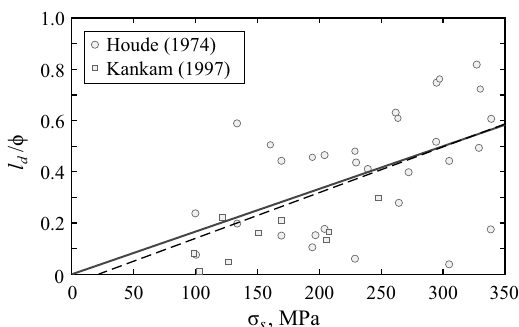
Figure 3. Debonding zone length normalized over reinforcement diameter against experimental strains in the reinforcement re- ported by Houde (1974) and Kankam